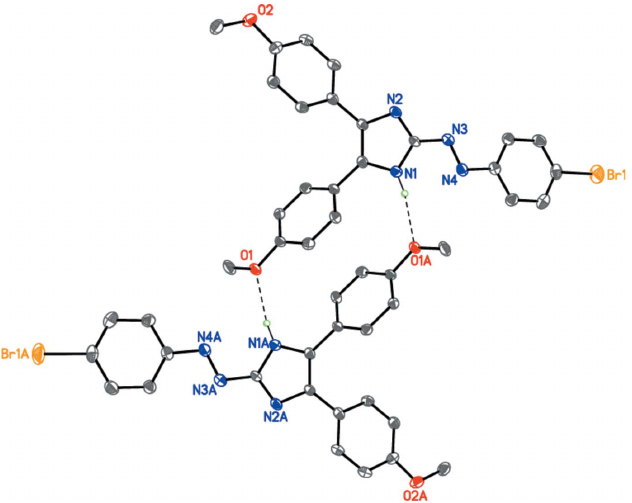
Figure 2 The hydrogen-bonded centrosymmetric dimer. Dashed lines indicate the N—H (cid:3)(cid:3)(cid:3) O hydrogen bonds.